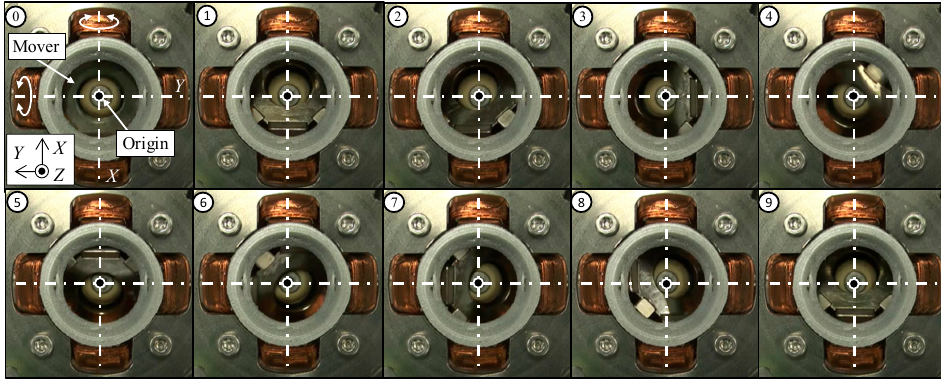
Figure 10. Operating verification of the multi-axes drive.